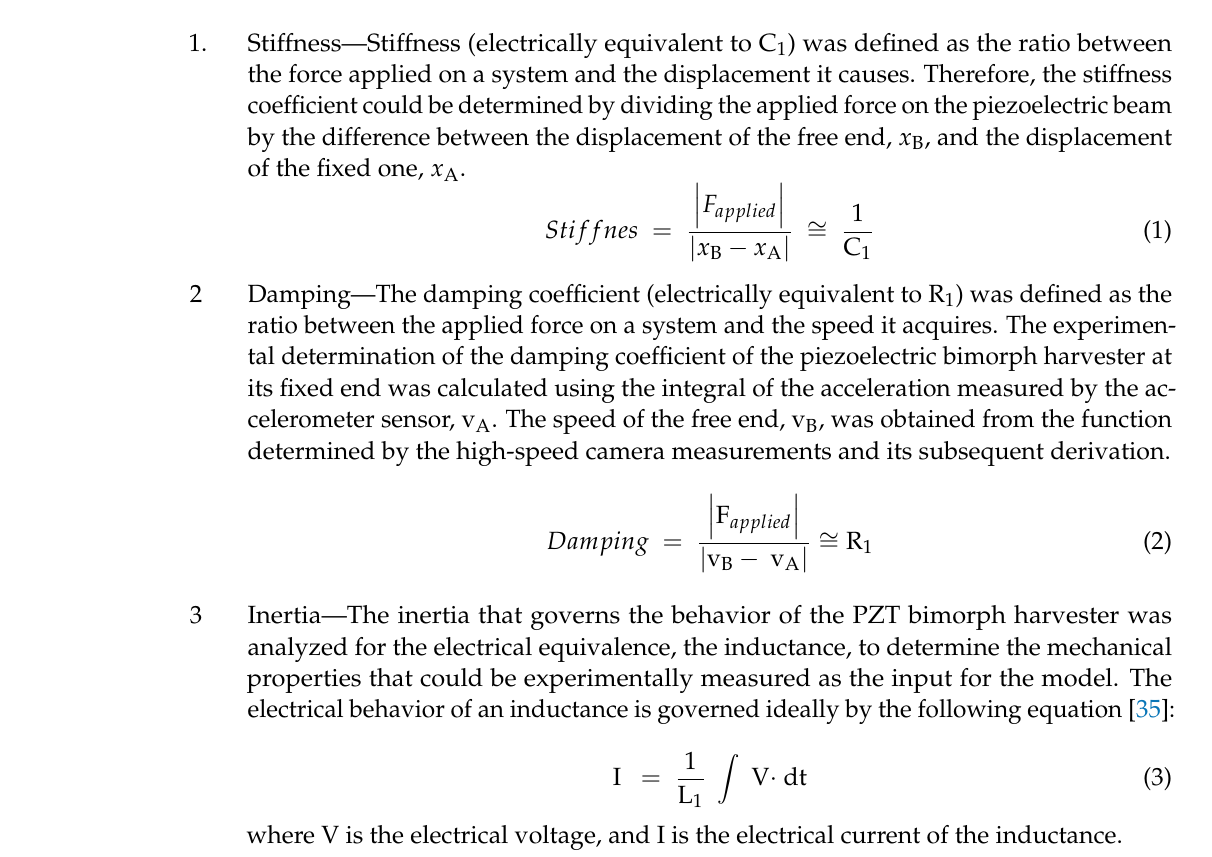
Stiffness—Stiffness (electrically equivalent to C 1 ) was defined as the ratio between